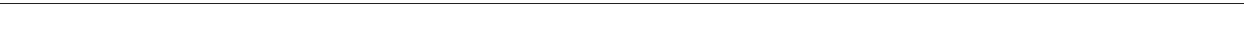
Fig. 3 GVHD-protective effect of SCFAs is mediated by GPR43. WT B6 and Gpr43 − / − mice received BMT from either syngeneic B6 or allogeneic BALB/c donors. a , b Survival and clinical GVHD score after BMT for WT B6 recipients treated with vehicle or GPR43 agonists (10 mg kg − 1 per day) from day 0